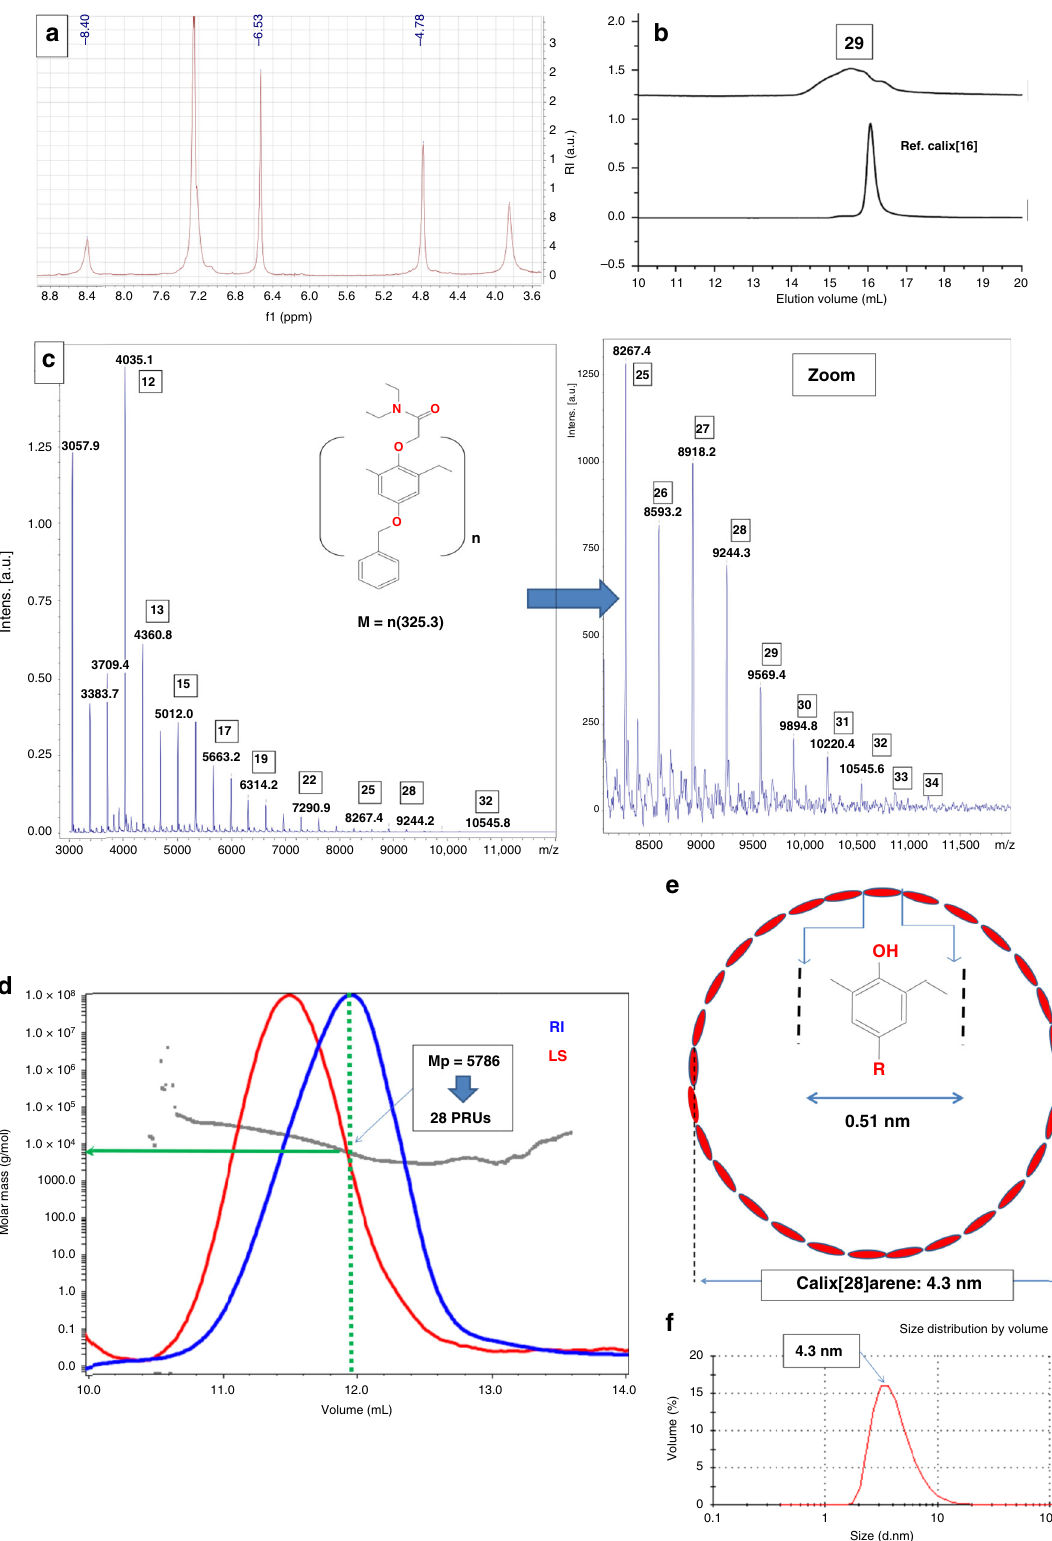
Fig. 5 Analysis of giant calixarenes synthesis (one-step process, 0.85 of RbOH vs phenol). a 1 H NMR (DMSO-d6); b SEC, and c linear mode MALDI-TOF MS analysis of giant calixarenes (Cs + cationized). d SEC-MALS analysis ; e DLS analysis (size distribution by volume); f the geometrical model used to fi t DLS results. PRU numbers are shown in the